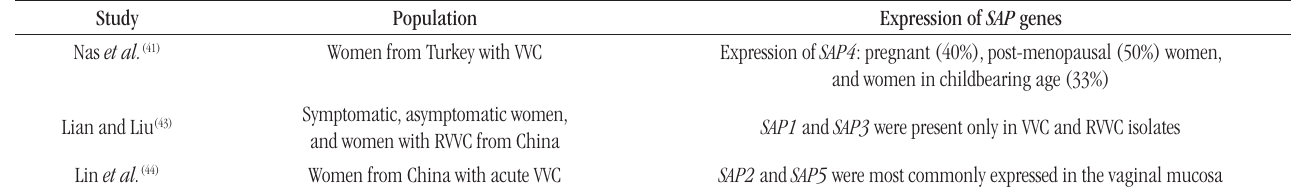
taBLE 5 − Expression of SAP genes in different studies